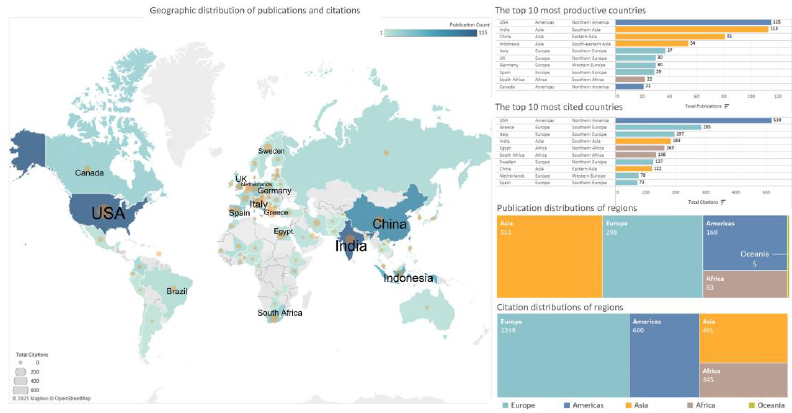
Figure 3. Geographic distribution of publications and citations.